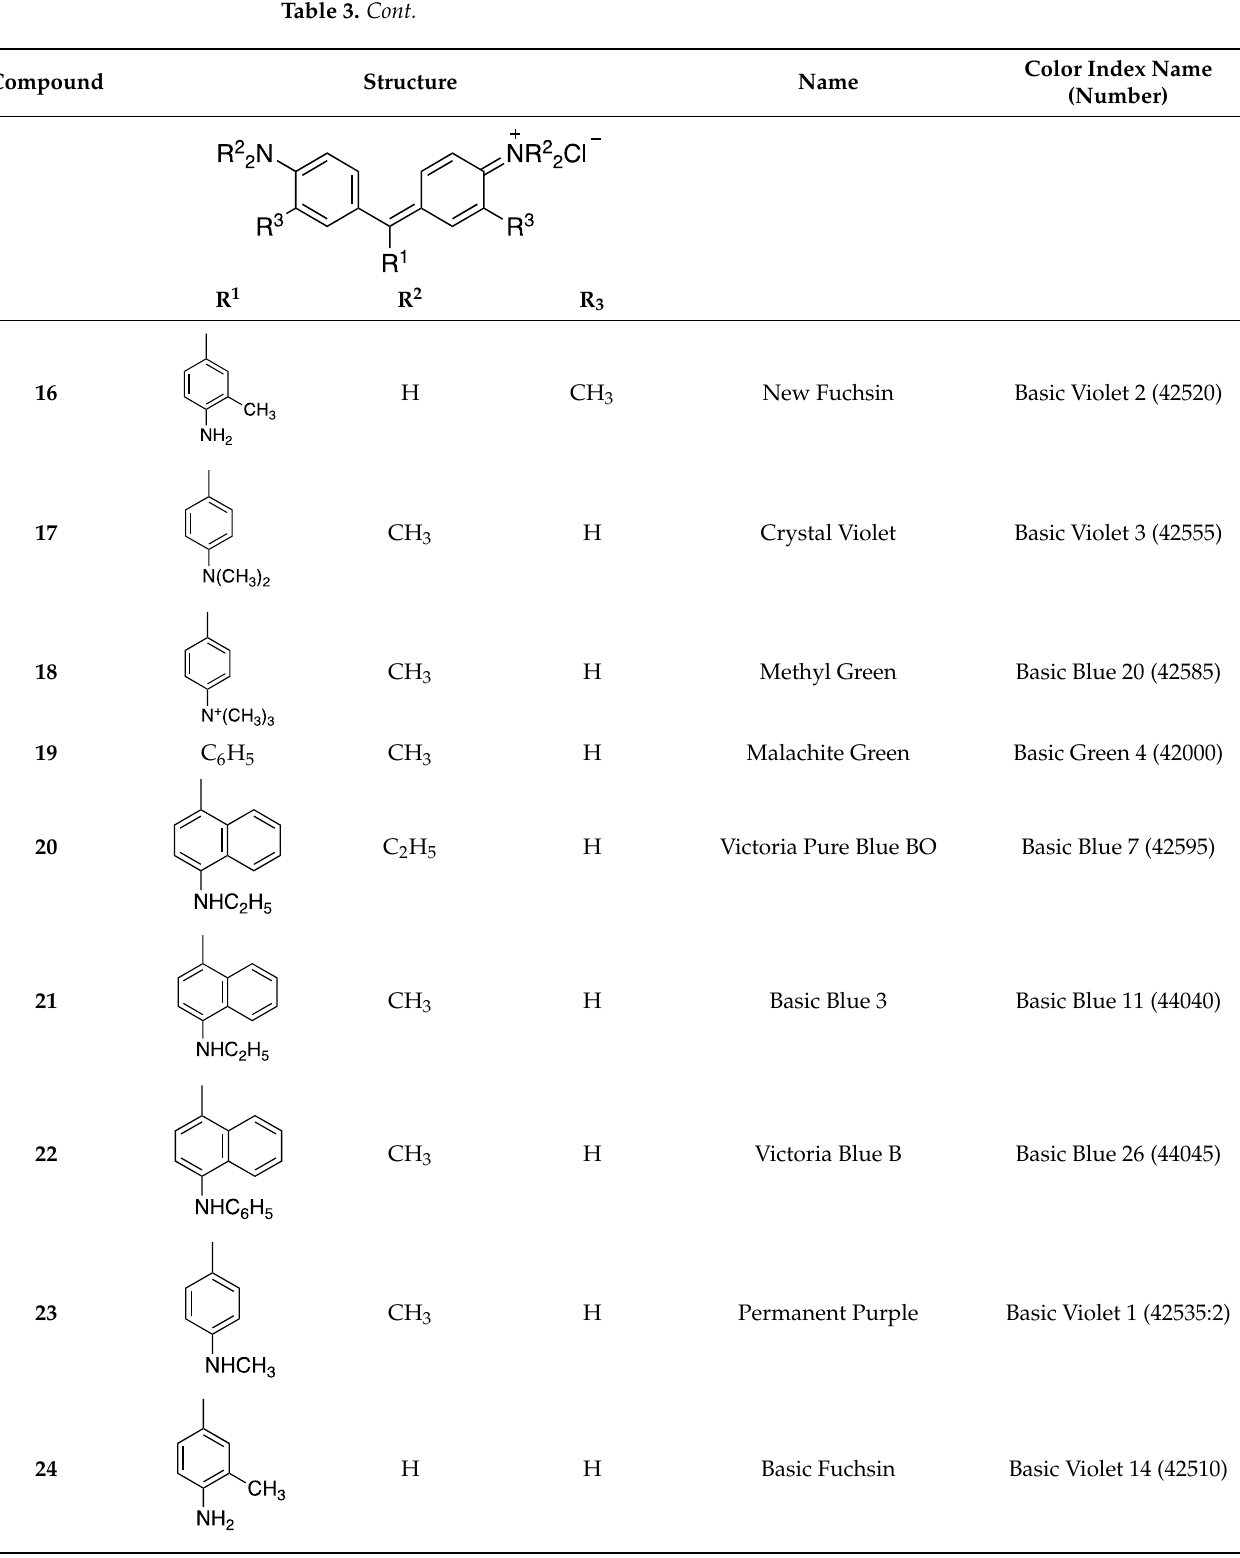
Table 3. Arylmethane textile Table 3. Cont.